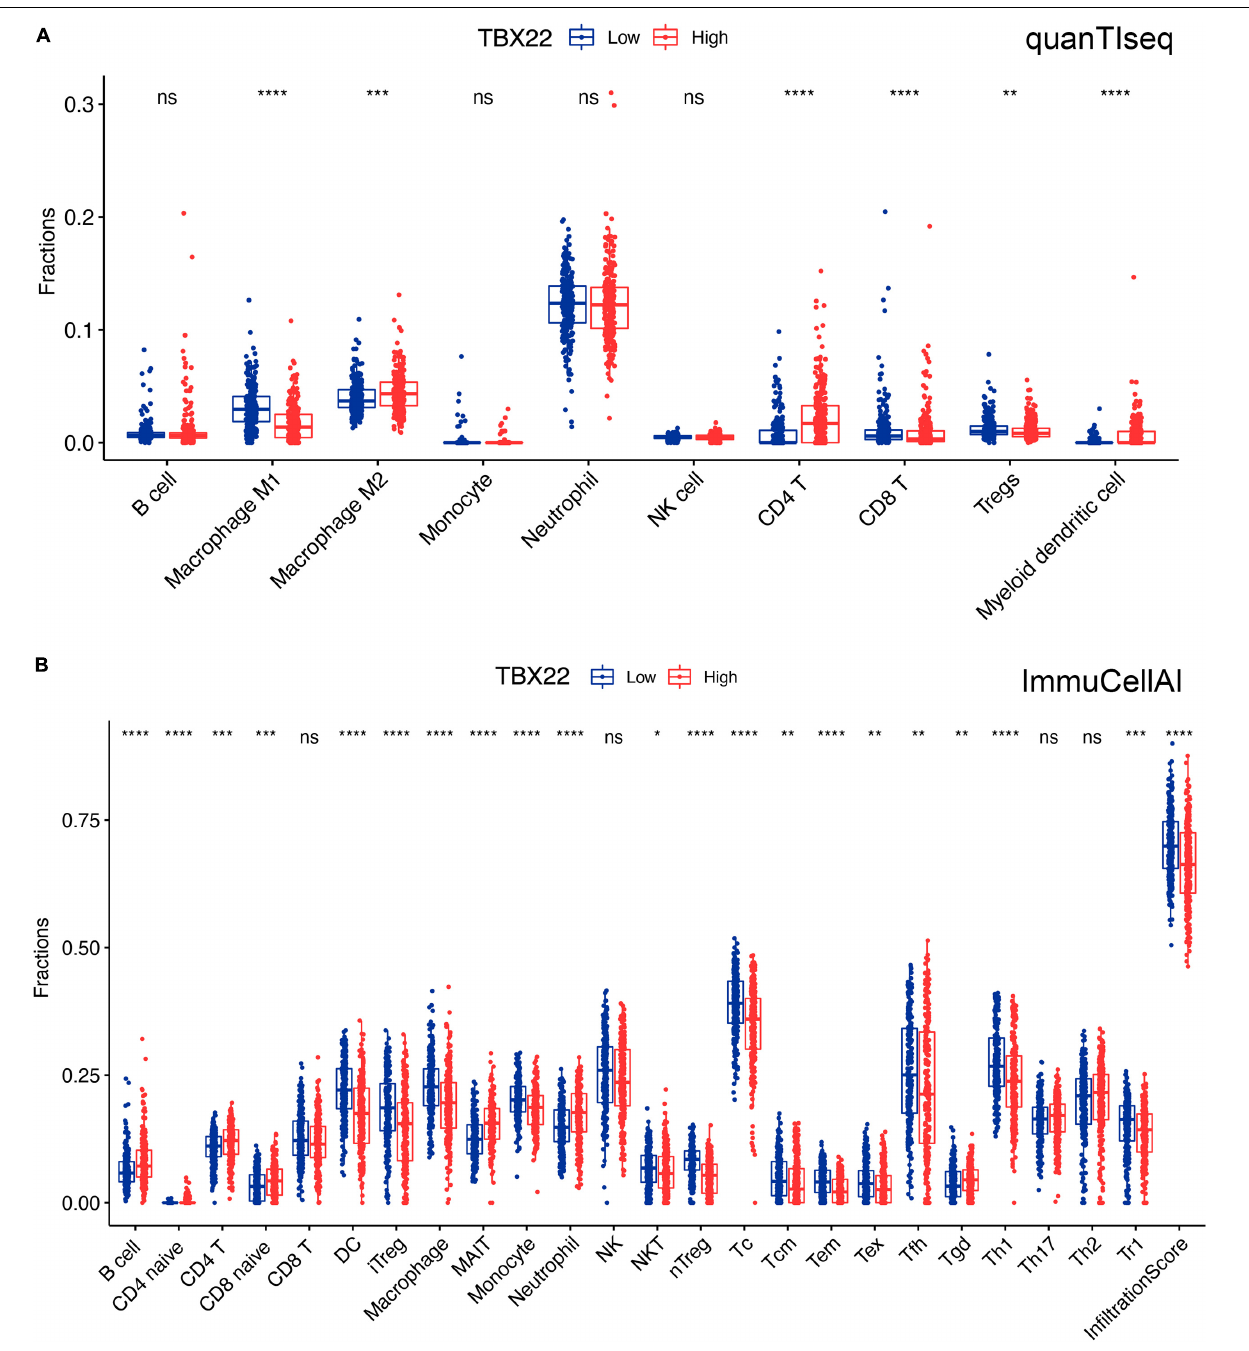
FIGURE 7 | Boxplots of immune cells in TBX22 high and TBX22 low PTC in TCGA cohorts. Comparison of the immune infiltrated cell components quantified by (A) quanTIseq and (B) ImmuCellAI in the TBX22 high and TBX22 low groups. * p < 0.05, ** p < 0.01, *** p < 0.001, **** p < 0.0001. The scattered dots represent all score values, and the thick line represents the median value within each group. The bottom and top of the boxes are the 25th and 75th percentiles (interquartile range). The difference between TBX22 high and TBX22 low groups was compared through the two-sided Wilcoxon rank-sum test.